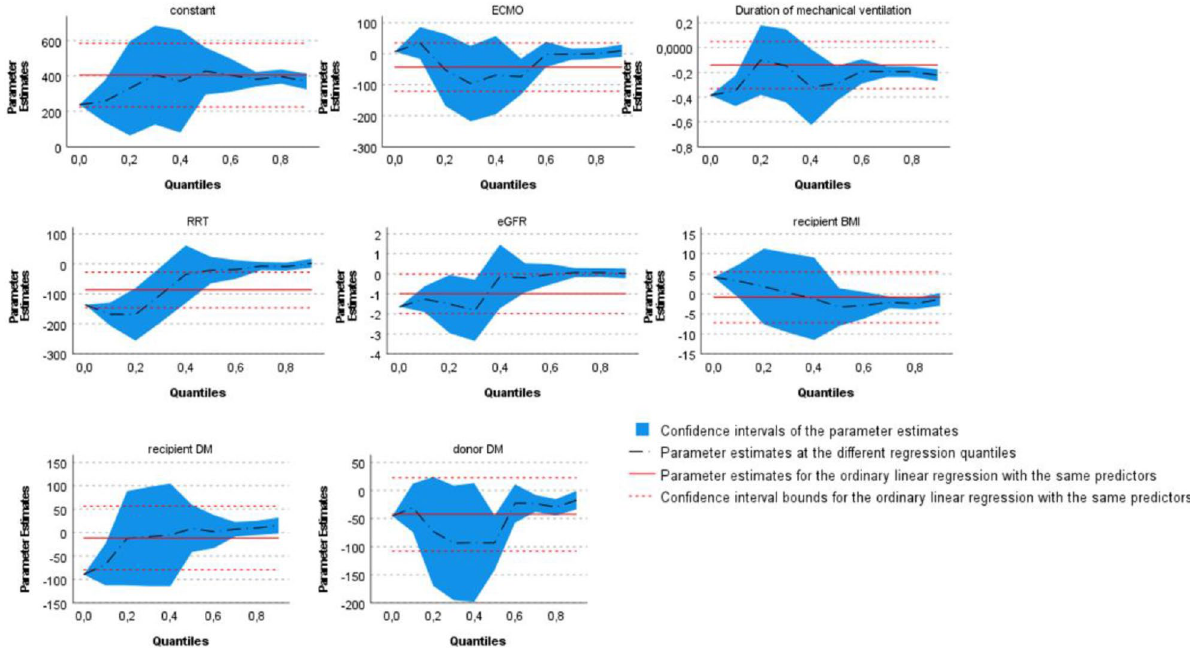
Figure 3. Association of variables with DAOH in multivariable quantile regression model. The figure shows the influence of selected variables on DAOH in a multivariable quantile regression model. Y-axis shows DAOH estimates while X-axis shows different quantiles. The black line represents parameter estimates at different regression quantiles. The Confidence intervals of quantile regression are presented in blue. Red lines